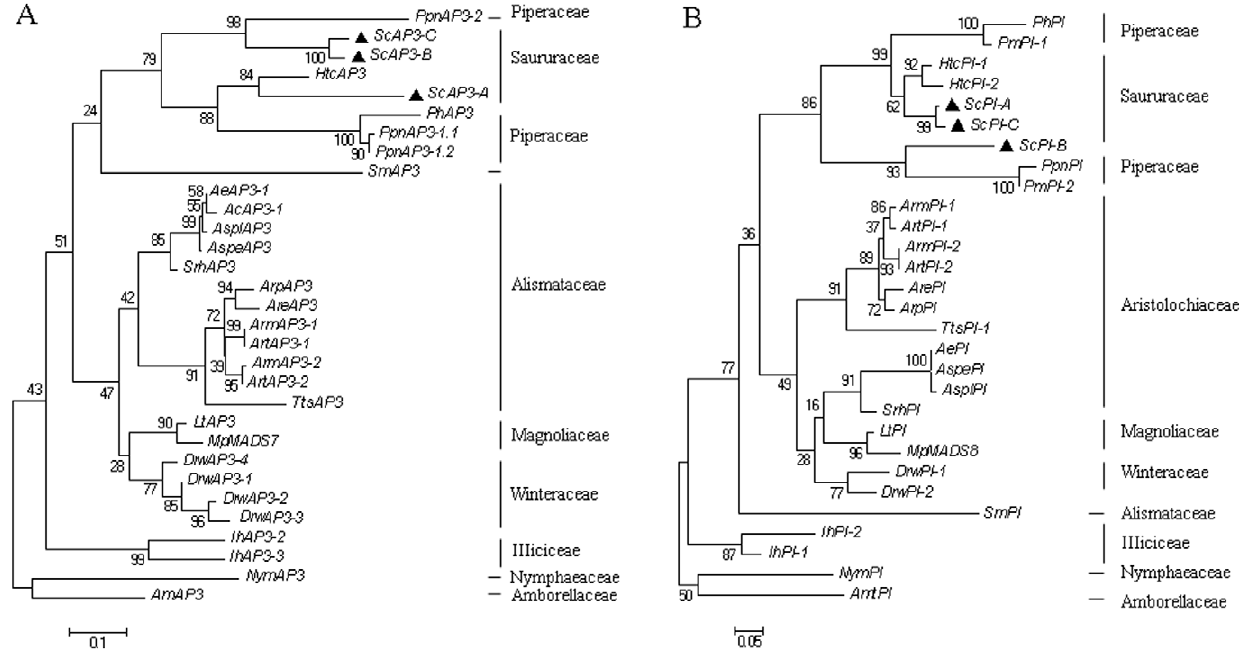
Figure 3. Maximum likelihood tree of B-class putative MADS-box transcription factors from S.chinensis and other basal angiosperm species. (A) Phylogenetic reconstruction of AP3 homologs from basal angiosperms using 226 sites. (B) Phylogenetic reconstruction of PI homologs from basal angiosperms using 420 sites. Numbers along branches represent bootstrap support values.